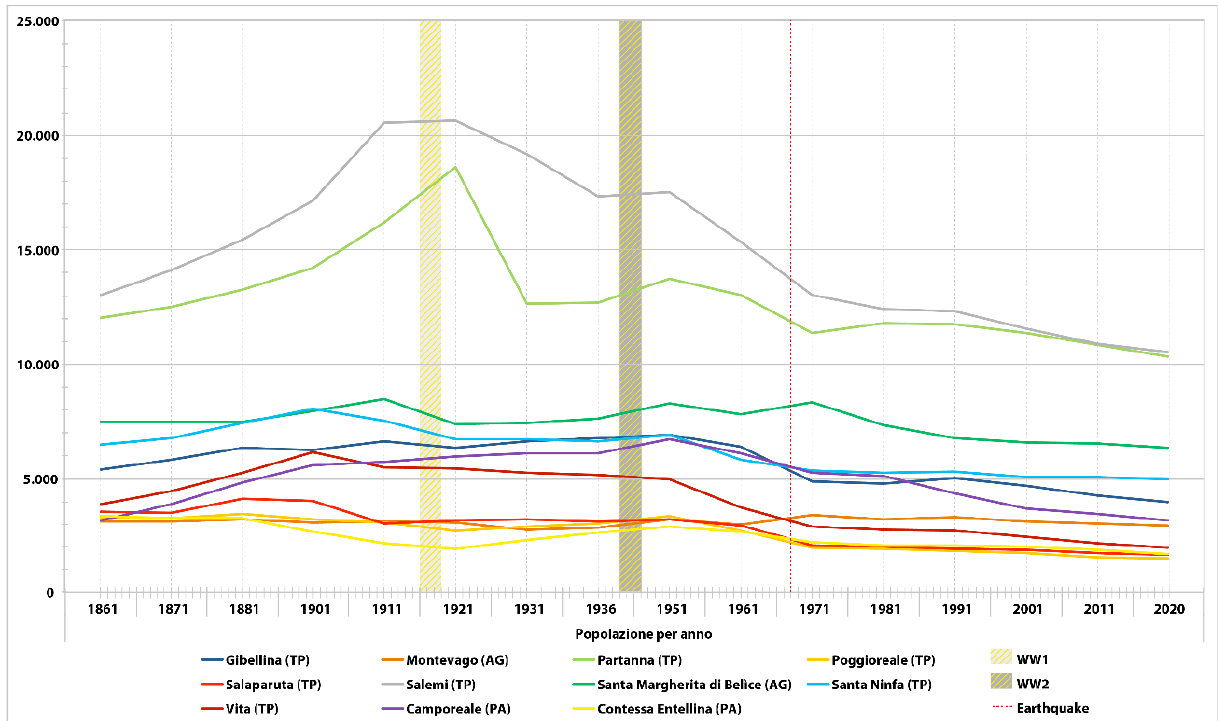
Figure 2. Population trends and relationships with major historical events (1861 – 2020). Source: ISTAT data.